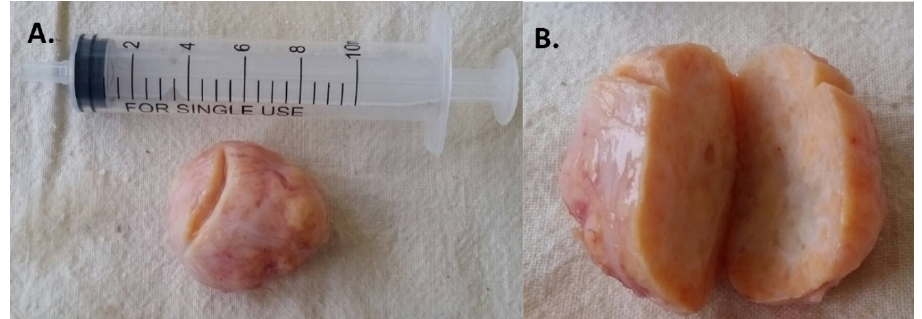
Figure 2. Macroscopic appearance of the removed fibrothecoma: ( A ) Oval node with smooth surface; ( B ) Yellow-gray in cross-section, solid structure.